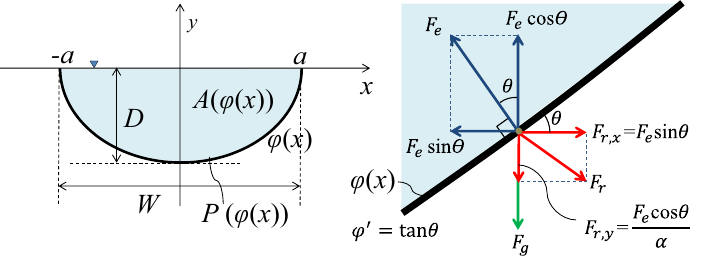
Figure 1. Schematic of the general channel cross section and forces acting on the channel